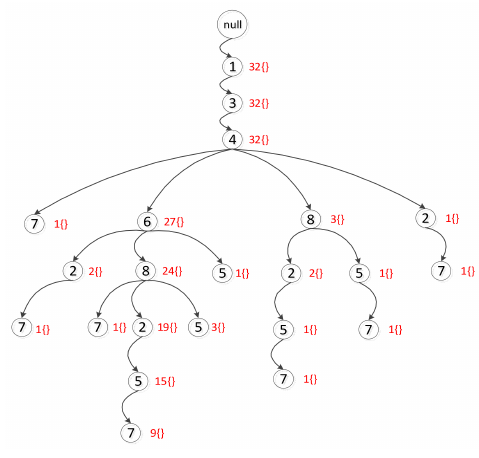
Figure 7. Constructing the